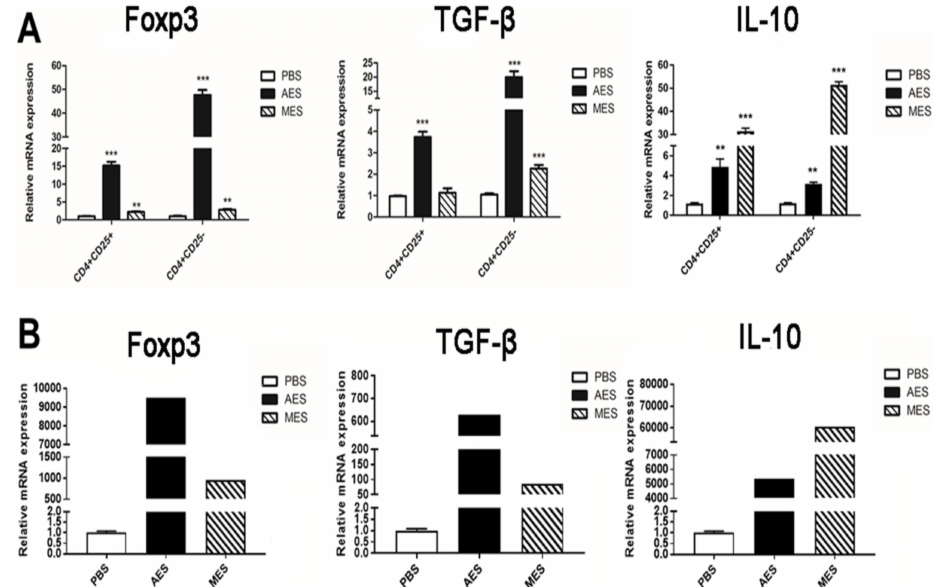
Figure 4. mRNA expression profile for Treg-related marker proteins in mice immunized with AES and MES: BALB / c mice were immunized with AES, MES, or PBS. ( A ) The CD4 + CD25 + and CD4 + CD25 − T cells were acquired by FACS, and the mRNA for Foxp3 + , TGF- β , and IL-10 was measured by RT-PCR. ( B ) CD4 + Foxp3 + T cells were isolated by FACS for mRNA analysis of Foxp3, IL-10, and TGF- β . Results are presented as means ± SDs from three independent experiments normalized to the level of HPRT 1. ** p < 0.01; *** p < 0.001, compared to the PBS